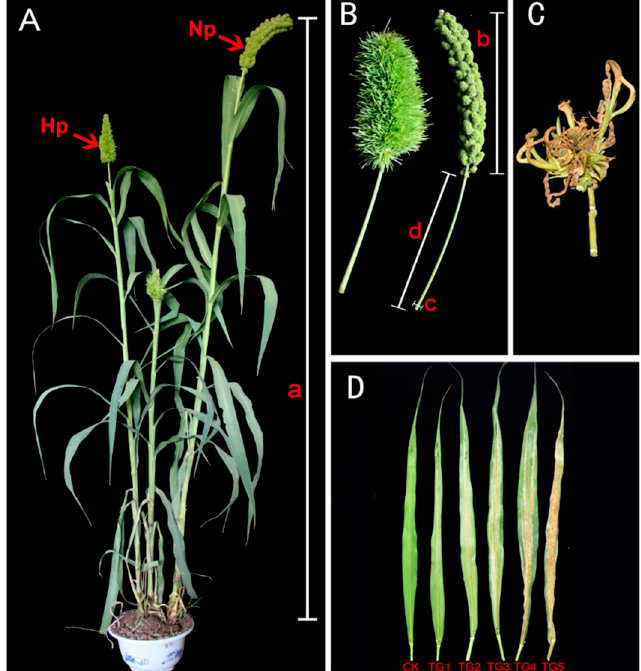
Figure 1. Downy mildew disease symptoms, “hedgehog panicle” and “gray back” in foxtail millet. ( A ) Healthy and downy mildew-infected foxtail millet plants, bearing normal panicle (Np) and “hedgehog panicle” (Hp), respectively. ( B ) Close-ups of “hedgehog head” and normal panicle, plant height (a), panicle length (b), panicle internode diameter (c), and length (d). ( C ) The panicle of witches’ broom. ( D ) Foxtail millet leaves showing the progression of “gray back” downy mildew symptoms. CK, uninfected healthy leaves; TG1–TG5, leaves at different stages of “gray back” development.